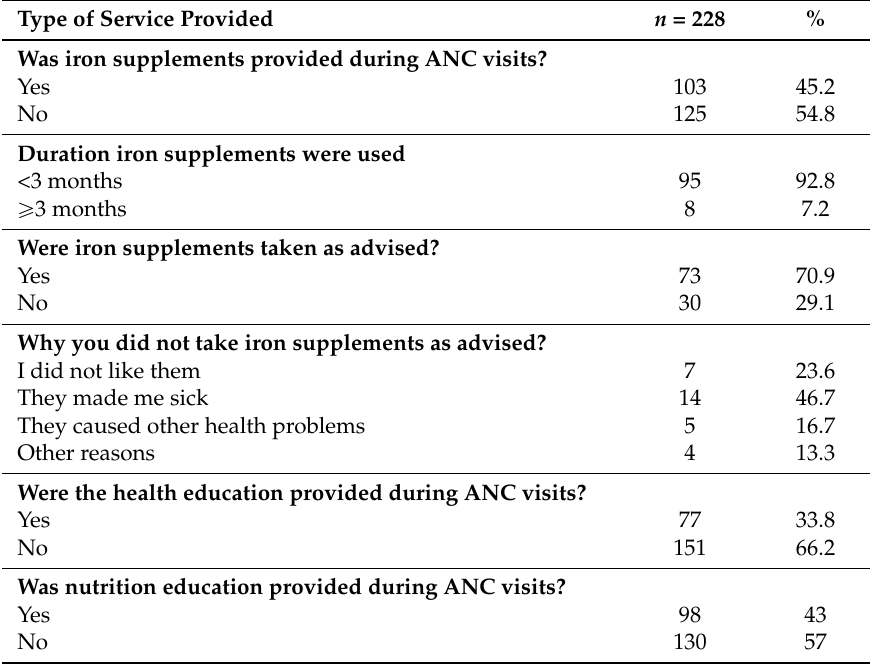
Table 4. Iron supplement and health education given during ANC visits among women in Simiyu region in